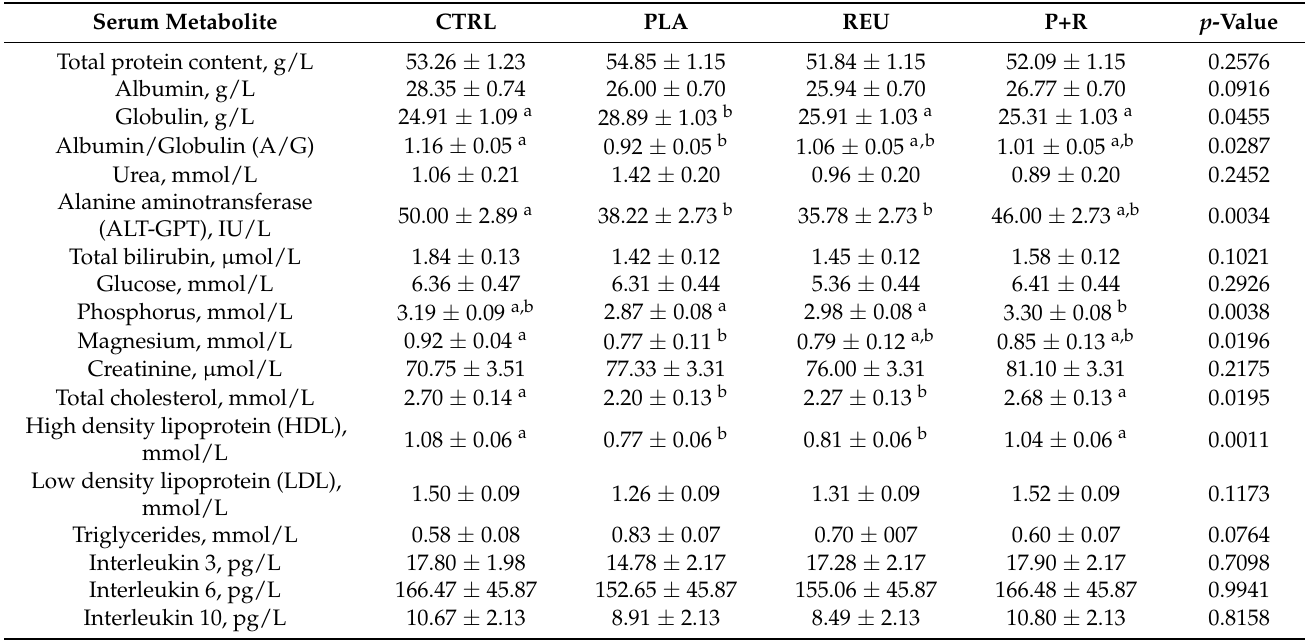
Table 3. Serum metabolites concentration at 28 days (T4) of in vivo trial, for the control (CTRL) and treatments groups (PLA, REU and